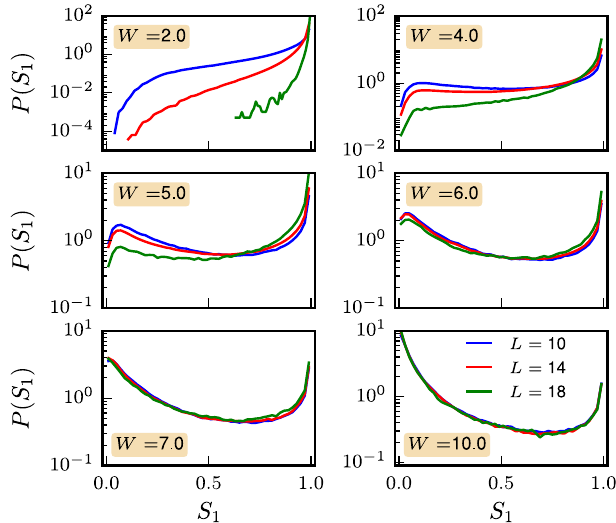
9. Probability distributions of the end-spin entanglement entropy S 1 for different W ’ s and L ¼ 10 , 14, 18 (blue, red, green curves). The distributions become extremely broad near the transition, with very little system size dependence, consistent with strongly subthermal mean values of S 1 in the quantum critical